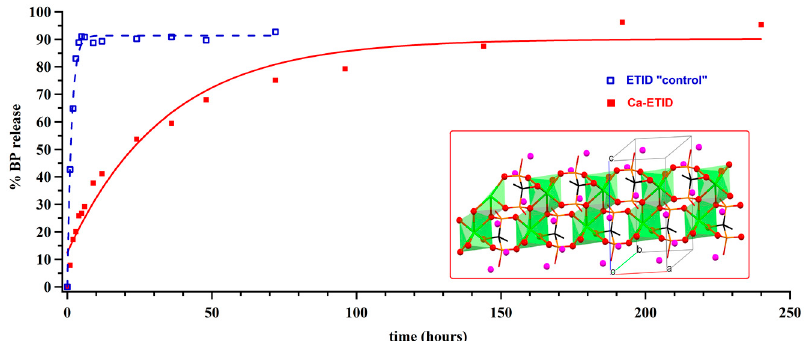
Figure 32. Etidronic acid (ETID) release versus time for the control tablet (dark blue circles) and the Ca–ETID tablet (light blue triangles). The crystal structure of Ca–ETID is also displayed in the inset. Colour code: calcium: green, phosphorus: yellow, oxygen: red, carbon: black, lattice water: pink. Adapted with permission from reference [139]. Copyright 2018, Walter de Gruyter GmbH and Co. KG.